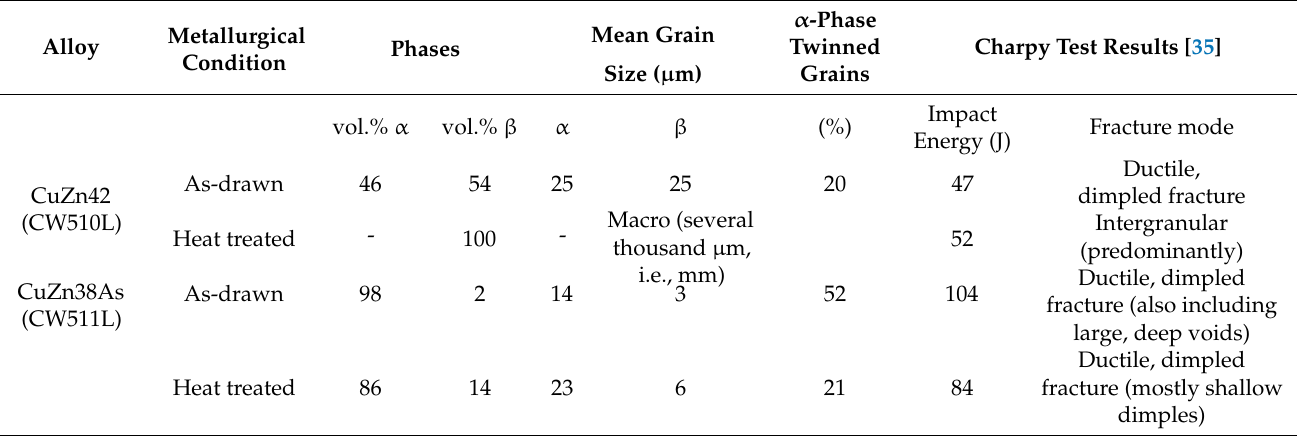
Table 3. Results of EBSD scans, % phase volume fractions, mean grain size, % twinned grains, and mechanical testing data.